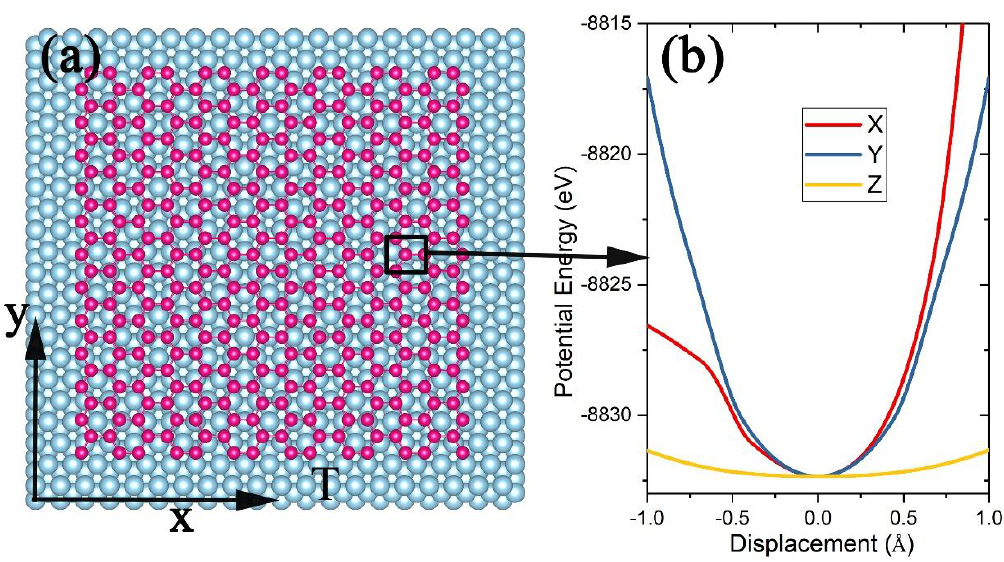
Figure 5. ( a ) Schematic of a piece of silicene of N atoms (red balls) lying on the surface of a Ag(111) substrate of M atoms (blue balls) at temperature T and ( b ) the potential energy felt by a Si atom (shown in the black box) moving along the X-, Y-, or Z-axis.